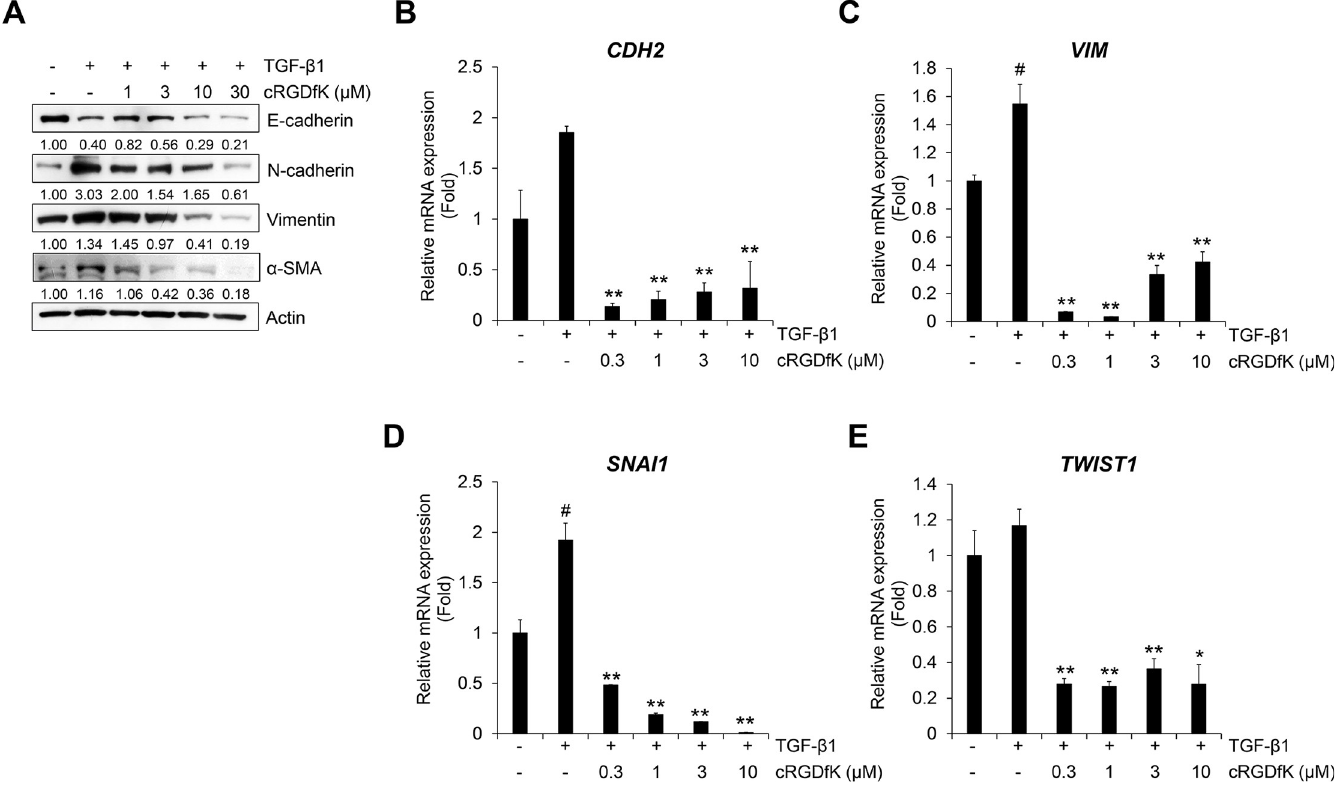
Fig 6. Treatment with cRGDfK inhibits TGF- β 1-induced expression of EMT markers. (A) Serum-deprived A549 cells were treated with TGF- β 1 (5 ng/mL) or its combination with cRGDfK for 72 h. The protein expression of TGF- β 1-mediatead EMT markers was detected by Western blot. Actin was used as a loading control. (B– E) Serum-deprived A549 cells were pretreated with cRGDfK for 3 h, and then treated with TGF- β 1 (5 ng/mL) for 48 h (B and C) or 1 h (D and E). The mRNA expression of CDH2 and Vim (B and C) or Snail and Twist (D and E) was measured by qRT-PCR using GAPDH as an internal control. Experiments were performed in triplicate. Data represent the mean ± SD of raw results. # p < 0.01 versus control, � p < 0.05, �� p < 0.01 versus treatment with TGF- β 1 only.